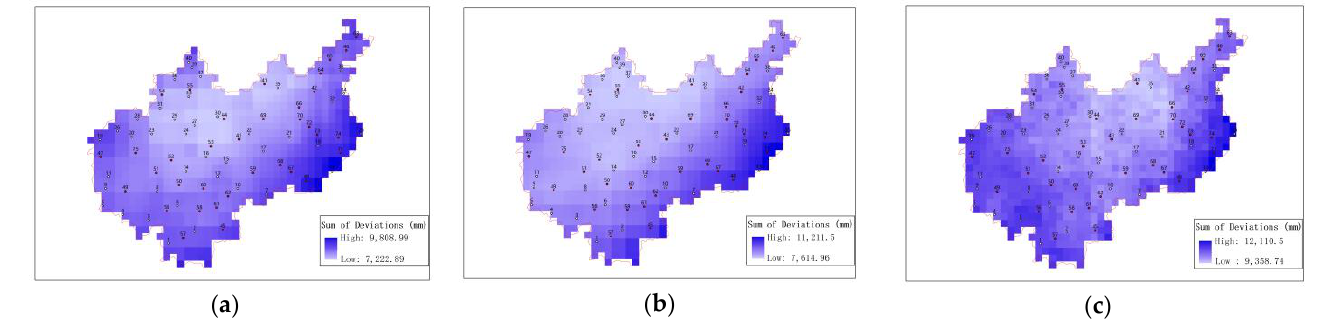
Figure 11. Spatial distributions of cumulative precipitation deviations for three sets of satellite- based data. ( a ) GPM IMERGE Early; ( b ) GSMaP_NRT; ( c ) PERSIANN − CCS. data. ( a ) GPM IMERGE Early; ( b ) GSMaP_NRT; ( c ) PERSIANN −